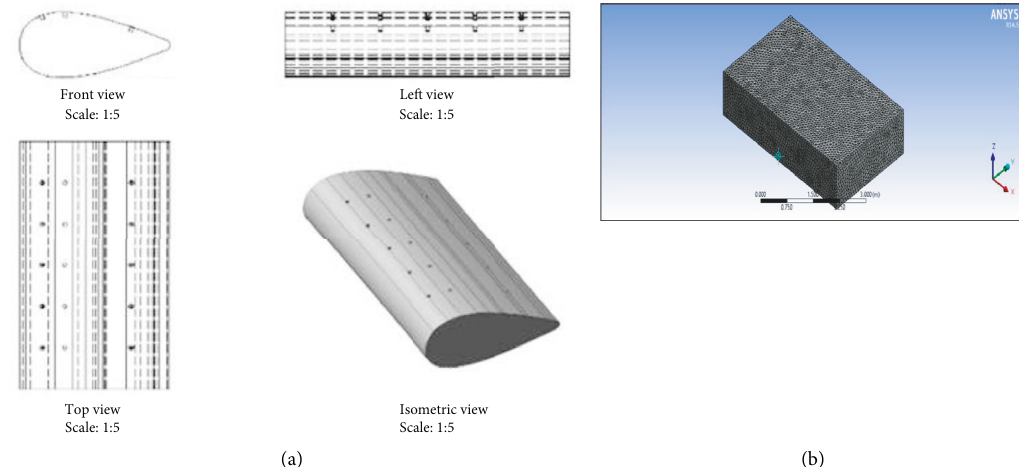
Figure 4: (a) Engineering drawing of an aerofoil with trickle channels. (b) Model after applying the mesh for NACA 0024 aerofoil.